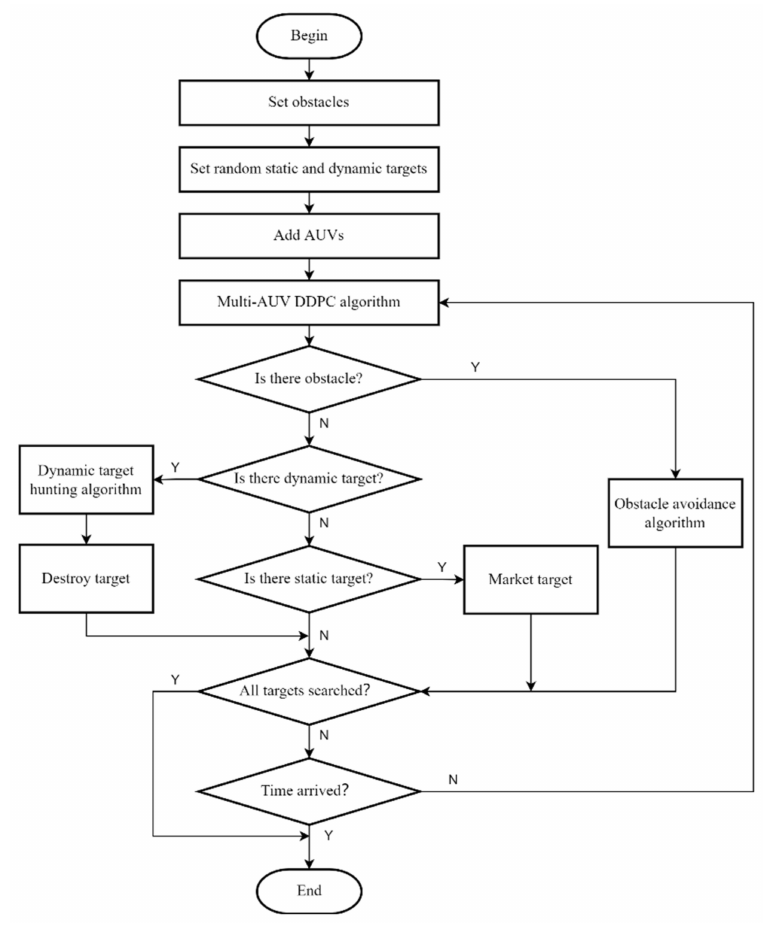
Figure 4. Search